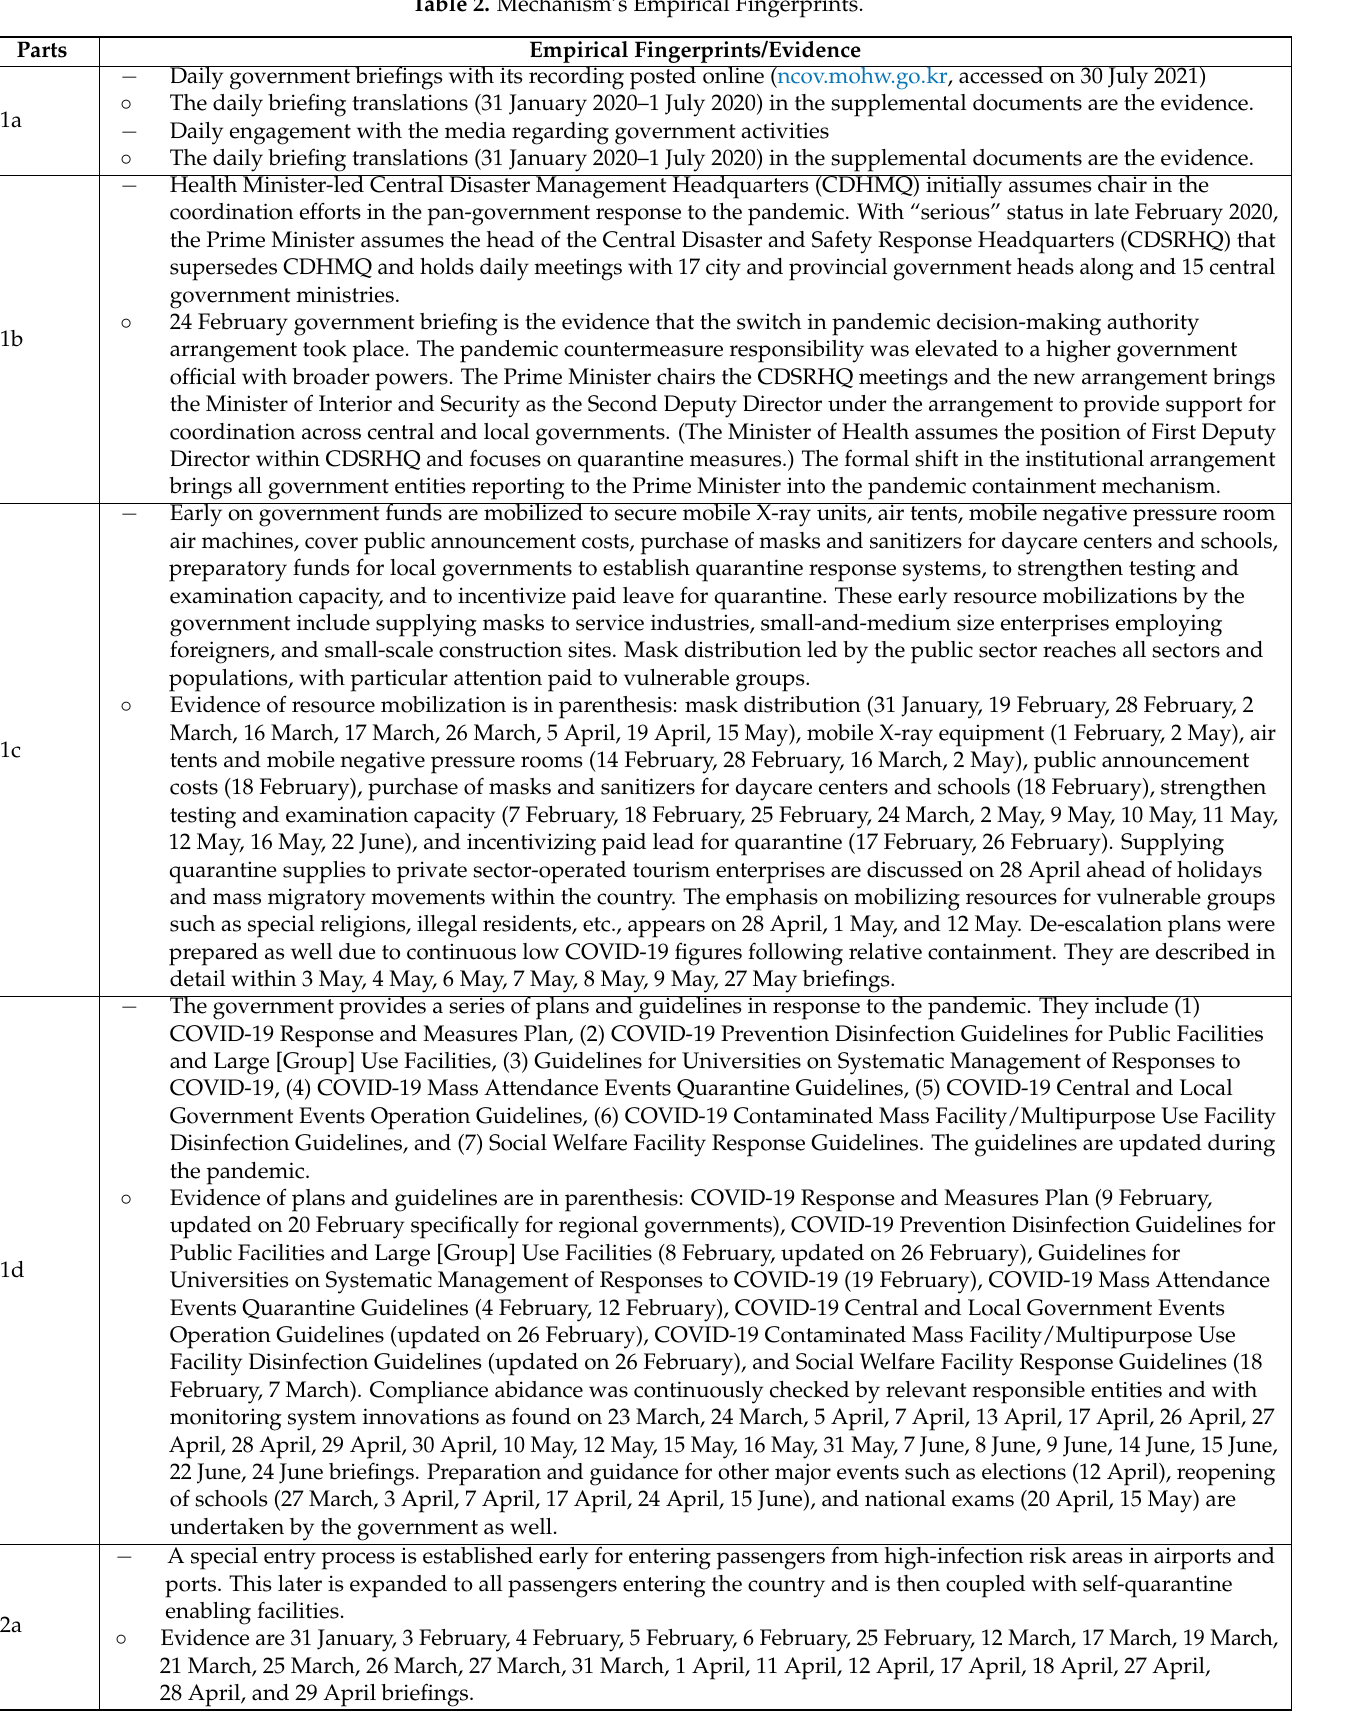
Table 2. Mechanism’s Empirical